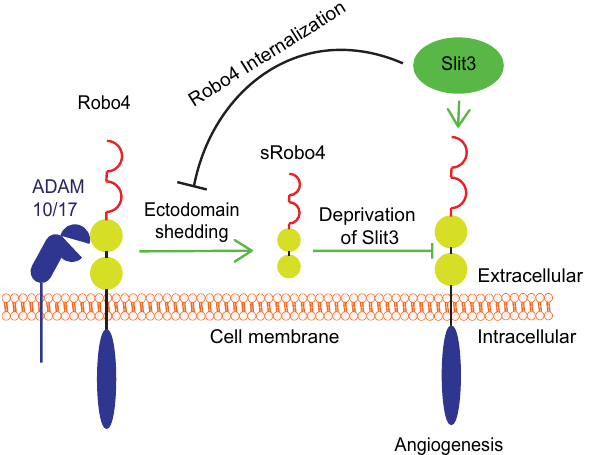
Figure 6. sRobo4 generation and its role in angiogenic Slit3-Robo4 signaling. Under the unstimulated condition, the Robo4 ectodomain is constitutively cleaved by ADAM10 and ADAM17 to generate sRobo4. The generated sRobo4 blocks Slit3-Robo4 interaction, thereby inhibiting angiogenic Slit3 signaling. Meanwhile, Slit3 inhibits Robo4 shedding by inducing Robo4 internalization to shield the receptor from